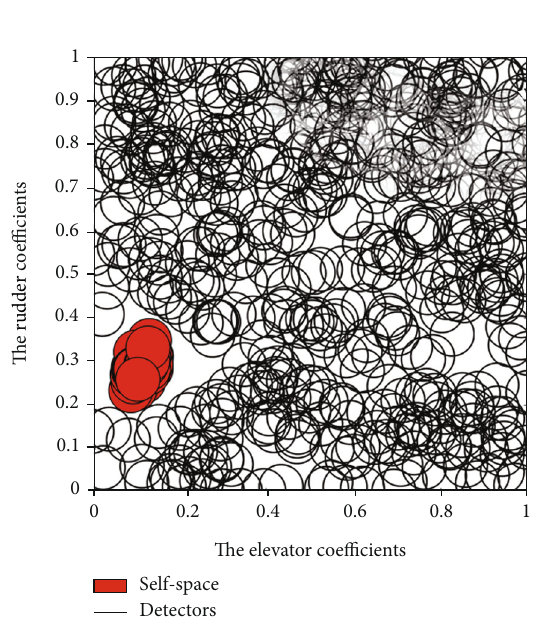
Figure 9: Self-space, detectors space, and fault sample space.